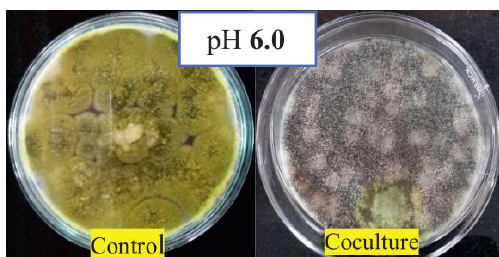
Fig. 9. Maximum antagonism of A. giganteus against pathogenic A. flavus (89.75%) at pH 6.0 showing arrested growth of pathogenic